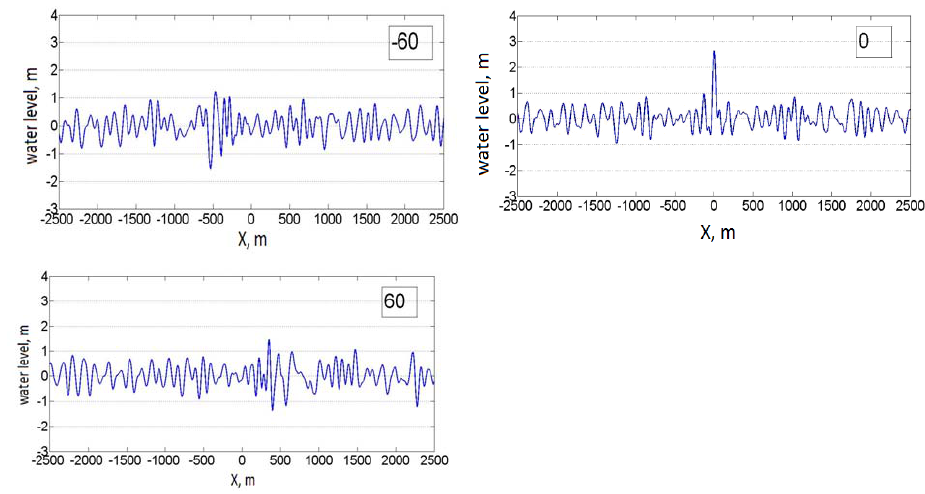
Fig. 4. Snapshots of the wave field at different times (s)